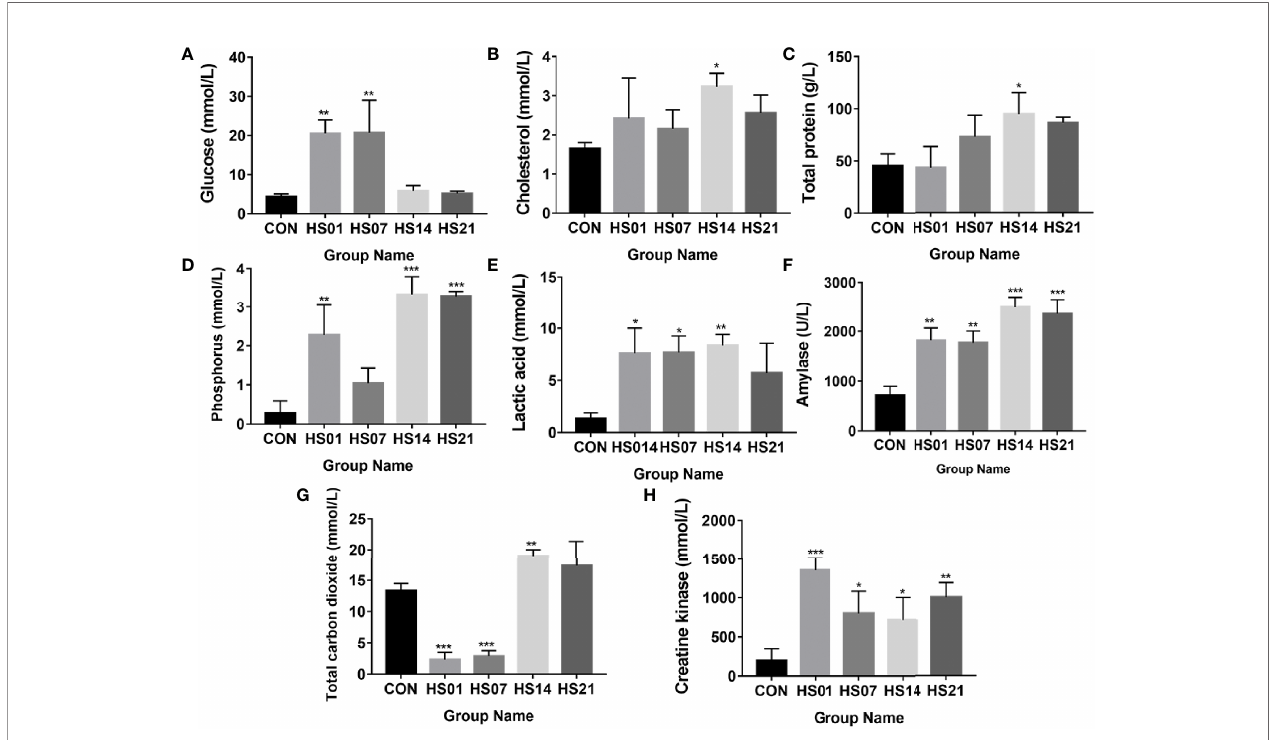
FIGURE 2 | Effect of HS on biochemical indexes in pig serum. CON indicates no heat stress group of day 1, HS1, 7, 14, 21 indicate heat stress day 1, 7, 14, and 21 groups respectively, n = 6; “ * ” indicates p < 0.05, “ ** ” indicates p < 0.01, “ *** ” means p < 0.001. (A) glucose; (B) cholesterol; (C) total protein; (D) inorganic phosphorus; (E) lactic acid; (F) amylase; (G) total carbon dioxide; (H) creatine